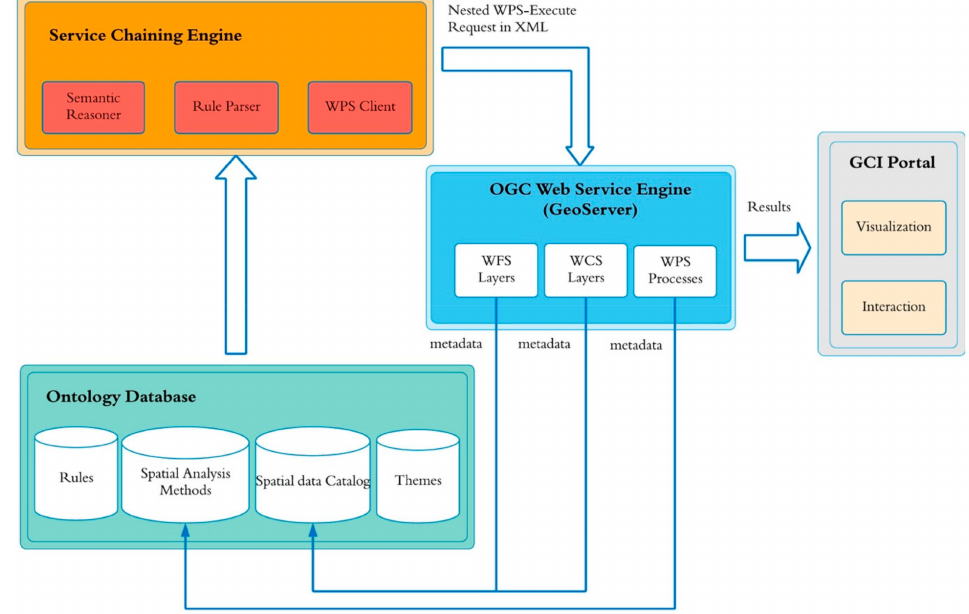
Figure 8. Architecture for the rule-based, semantic-enabled workflow generation, execution and visualization